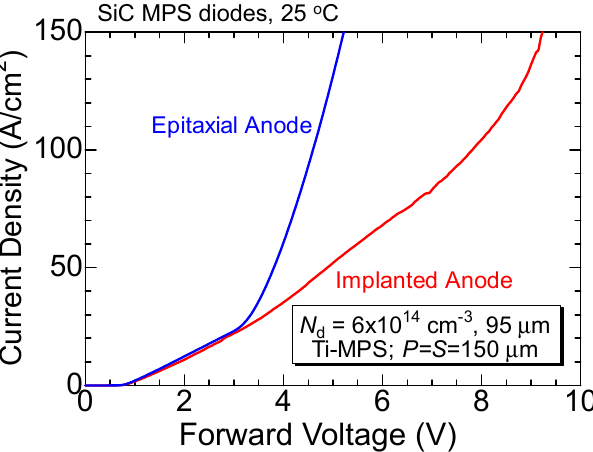
Figure 8. Forward characteristics for two types (epitaxial or implanted anode) of SiC MPS diodes fabricated in this study. The widths of the pin-region ( P ) and JBS region ( S ) were both 150 µm.